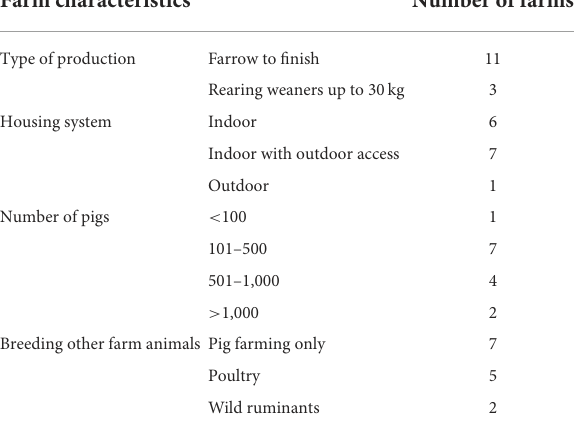
TABLE 1 Characterization of the visited pig farms ( n =